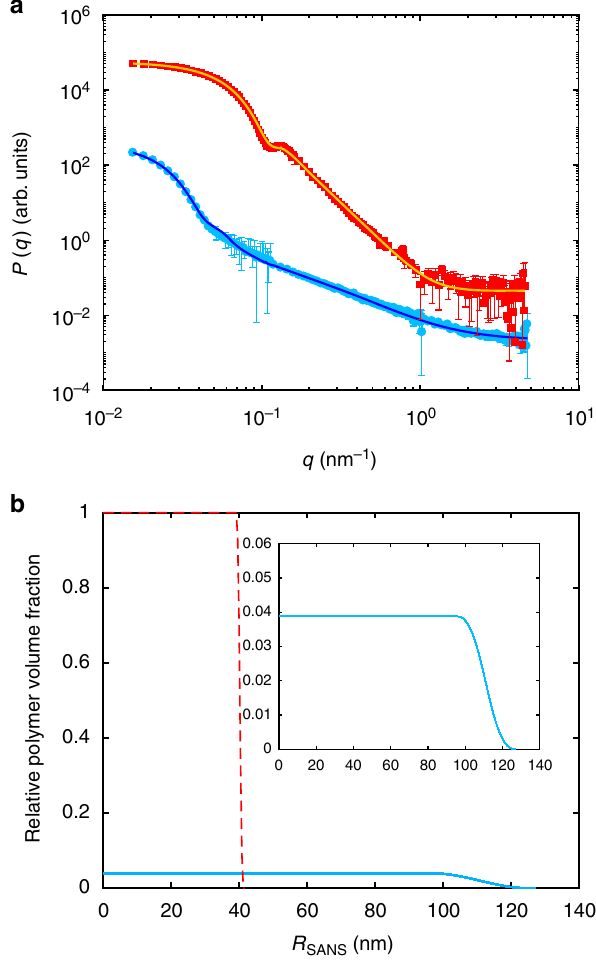
Fig. 1 Small-angle neutron scattering data and analysis. a Small-angle neutron scattering form factor, P ( q ), versus scattering vector, q , for ultra-low crosslinked (ULC) microgels in dilute suspensions of D 2 O at 20.0±0.5°C, light blue points, and 40.0 ±0.5 °C, red squares. The solid lines are fi ts with the fuzzy sphere model 22 . b Relative polymer volume fraction versus radius obtained from the data fi t for ULC microgels at 20.0± 0.5 °C, light blue solid line, and 40.0 ±0.5 °C, red dashed line. Inset: zoom of the relative polymer volume fraction versus radius for the ULC microgels below the volume phase transition temperature